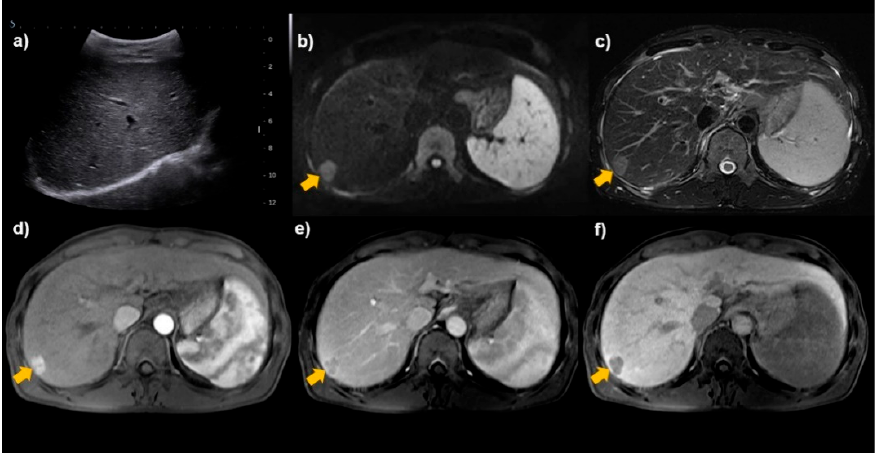
Figure 5. A 60-year-old male patient with chronic hepatitis B. ( a ) No focal hepatic le- sion was found in surveillance ultrasonography due to poor sonic window. ( b – f ) in surveillance ultrasonography due to poor sonic window. ( b – f ) Surveillance MRI detected a Surveillance MRI detected a 2.0 cm nodule in segment VII (arrows). MRI shows dif- 2.0 cm nodule in segment VII (arrows). MRI shows diffusion restriction ( b ) and mild-to-moderate fusion restriction ( b ) and mild-to-moderate T2 hyperintensity ( c ) with arterial-phase T2 hyperintensity ( c ) with arterial-phase hyperenhancement ( d ), portal venous washout ( e ), and hyperenhancement ( d ), portal venous washout ( e ), and hepatobiliary-phase hy- hepatobiliary-phase hypointensity ( f ), suggesting pointensity ( f ), suggesting HCC.